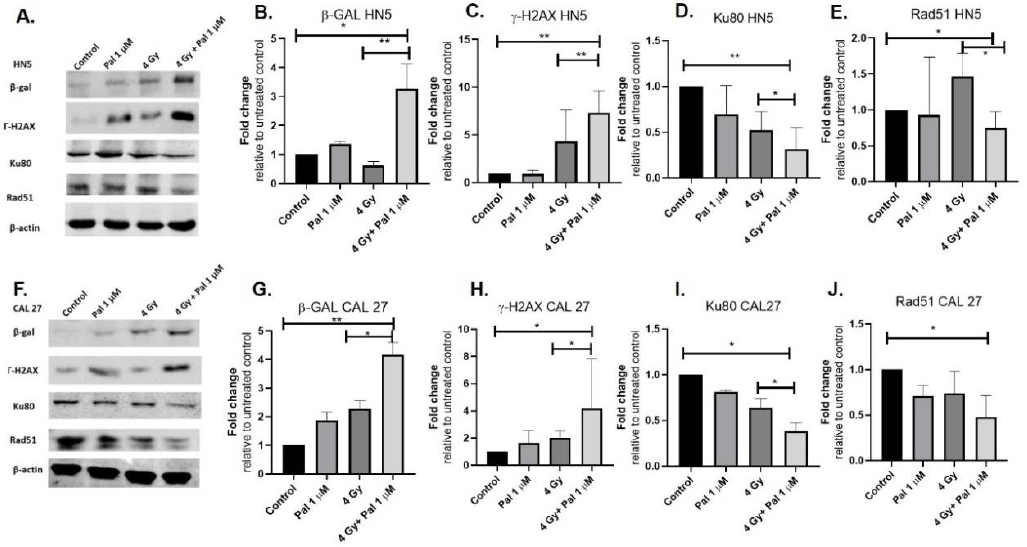
Figure 3. Palbociclib induces senescence in HPV (-) OCSCC and results in increased DNA damage and repression of key DNA damage repair proteins. HN5 and CAL27 western blots demonstrated increased SA β -gal expression after 72 h palbociclib treatment ( A , B , F , G ).The uncropped blots are shown in Supplementary Materials. Quantification of western blots for HN5 ( B – E ). Palbociclib/RT (4 Gy + 1 µ M palbociclib) for 72 h in HN5 demonstrated increased γ -H2AX expression consistent with increased DNA damage induction ( A , C ); reduced expression of NHEJ signaling molecule Ku80 ( A , D ) and HR signaling molecule Rad51 ( A , E ). Quantification of western blots for CAL27 ( G – J ). Palbociclib/RT (4 Gy + 1 µ M palbociclib) for 72 h in CAL27 demonstrated increased γ -H2AX expres- sion consistent with increased DNA damage induction ( F , H ); reduced expression of NHEJ signaling molecule Ku80 ( F , I ) and HR signaling molecule Rad51 ( F , J ). Analysis by two-tailed t -test. * p < 0.05; ** p < 0.01. Each data point represents the average represented from three individual